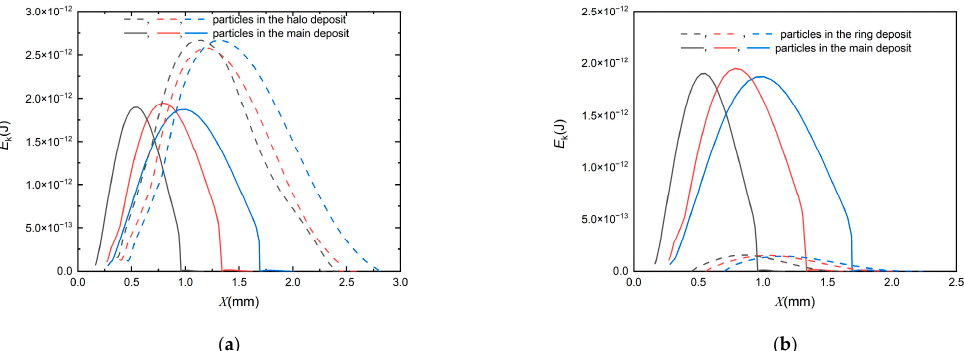
Figure 12. The kinetic energy of a particle changes with the particle location on the plate after the first particle–wall collision. ( a ) for “halo”. ( b ) for “halo” and